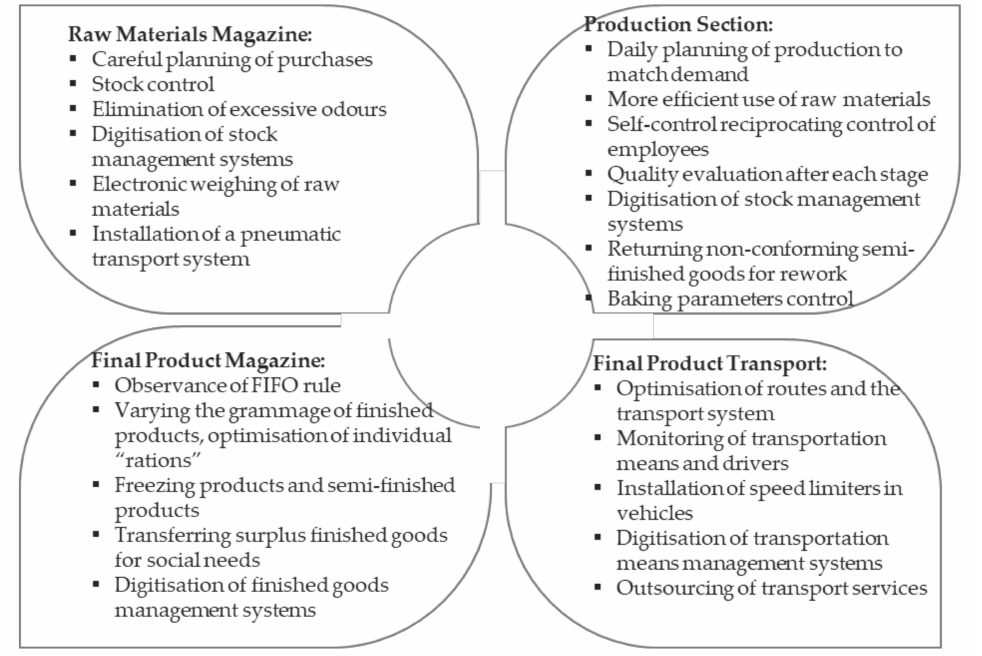
Figure 2. Toolkit to prevent and reduce food losses in bakeries and